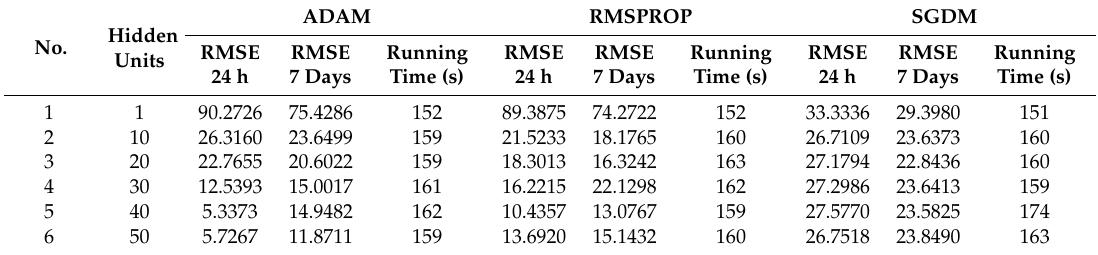
Table A1. The experimental results for the 20 developed LSTM ANNs per each training algorithm.